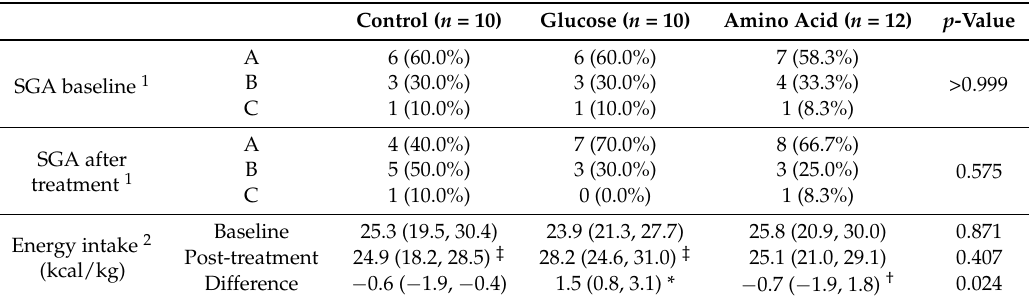
Table 2. Comparison of changes in median of the SGA nutritional status for the three treatment groups.